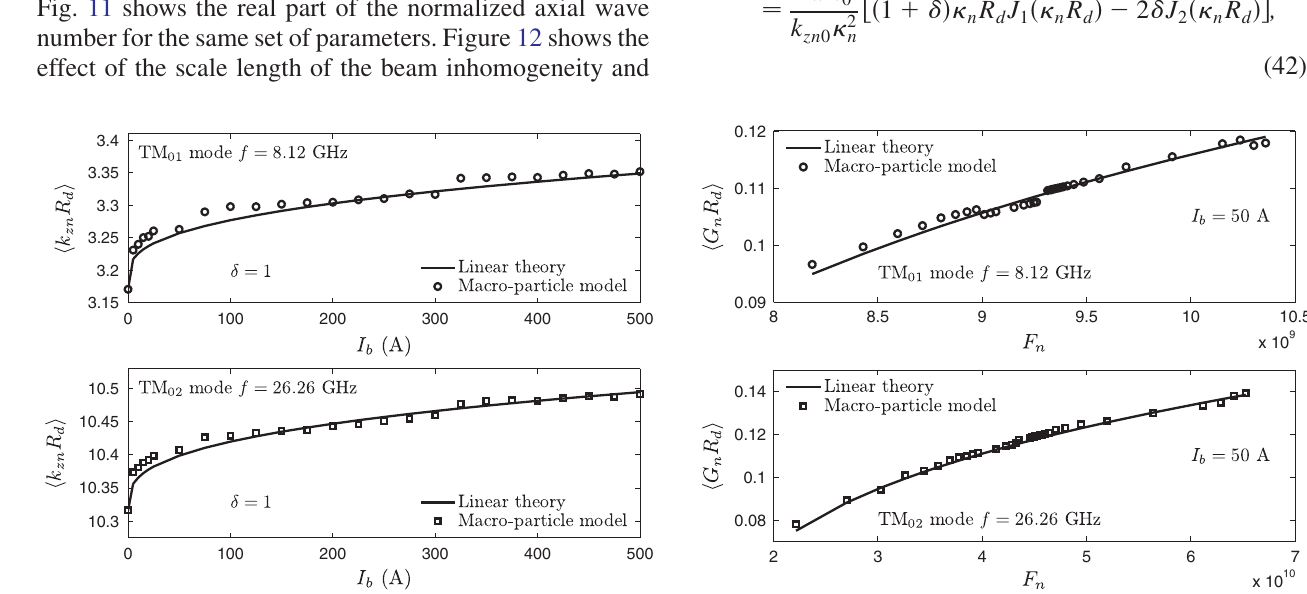
FIG. 11. Normalized wave numbers for TM 01 and TM 02 modes as a function of beam current for (cid:1) ¼ 1 .